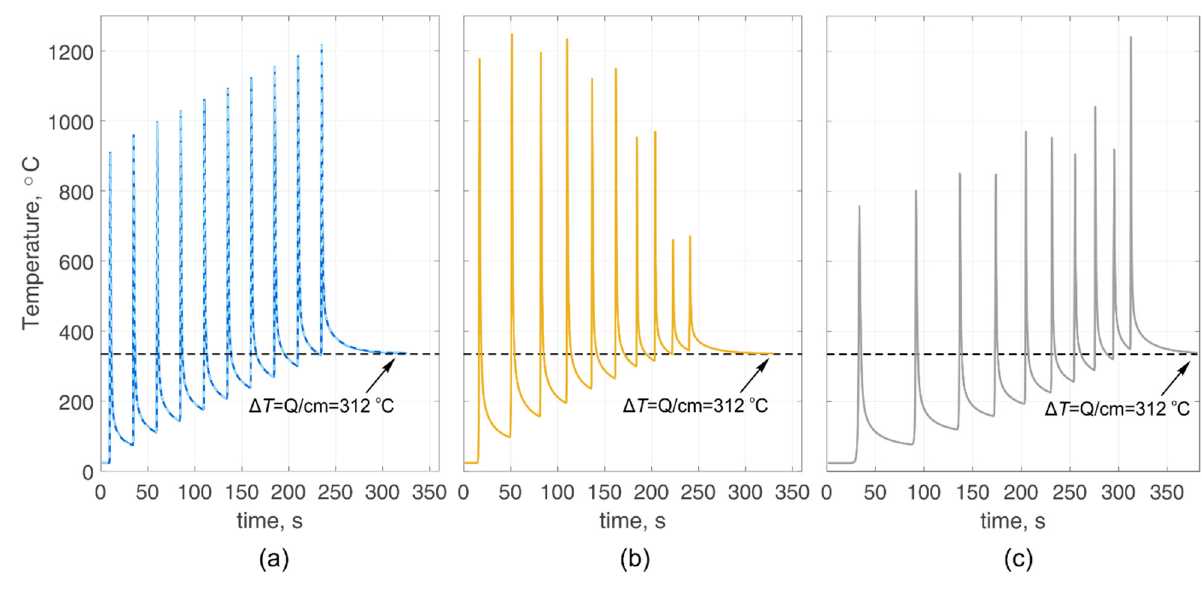
Figure 6. Calculated temperature cycles for arbitrary different modes: ( a ) mode 1 (the actual substrate and the truncated substrate); ( b ) mode 2; ( c ) mode 3.